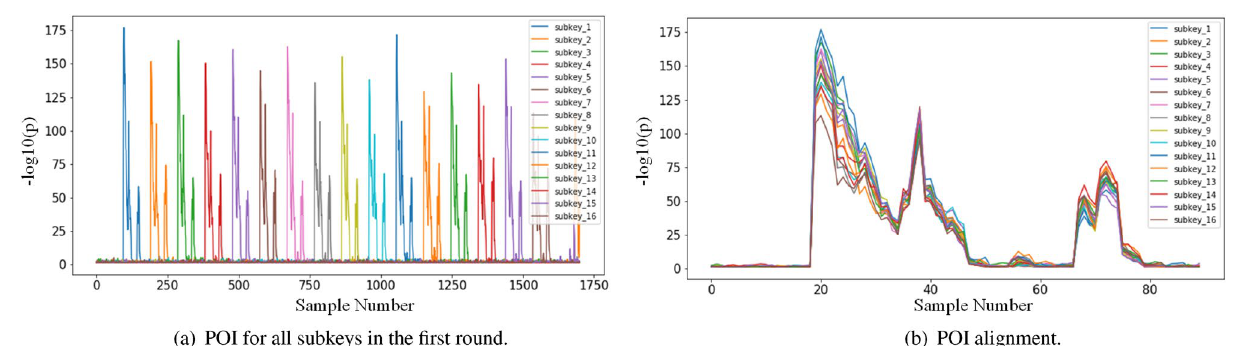
Figure 7. The result of all subkey POI and the result of POI alignment (AES_XMEGA).